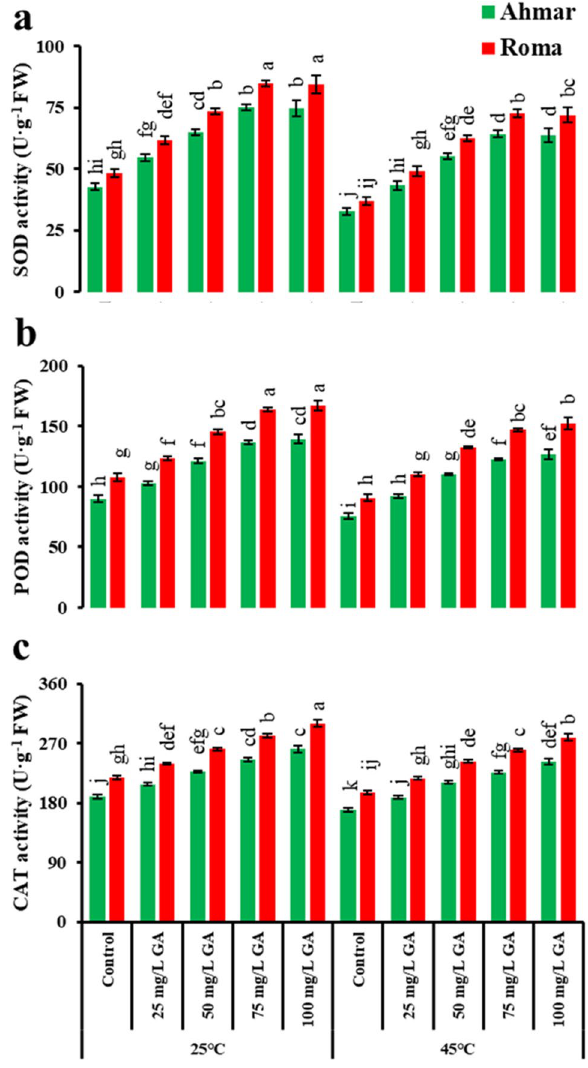
Figure 5. Activities of antioxidant enzymes in tomato as affected by temperature, genotype and exogenous application of GA 3 . According to Tukey’s honestly significant difference test, the same letters suggest that there is no statistically significant difference between treatments ( p ≤ 0.05). Vertical bars indicate average ± standard error (n = 4, 5 plants per